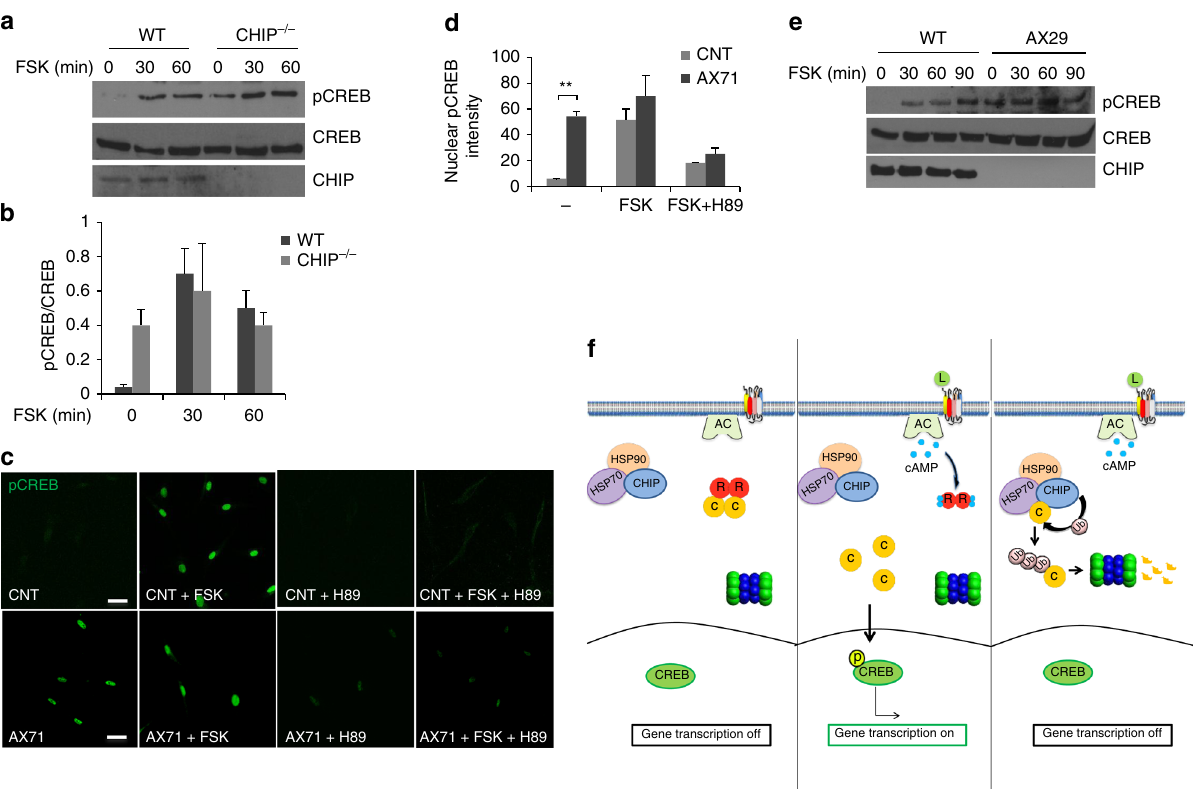
Fig. 8 Deregulated cAMP signaling in CHIP KO mice and in SCAR16 fi broblasts. a Mouse embryonic fi broblasts (MEFs) isolated from control mice (WT) or from CHIP KO mice (CHIP − / − ) were serum deprived overnight and then stimulated with FSK (40 μ M). Lysates were immunoblotted for pCREB, CREB, and CHIP. b Quantitative analysis of the experiments shown in a . A mean value ± S.E.M. of three independent experiments is shown. c Primary fi broblasts isolated from healthy volunteers (CNT) or from SCAR16 patient (AX71) were serum deprived overnight and stimulated with FSK (40 μ M) for the indicated time points. Where indicated, cells were pretreated with H89 (10 μ M). Formalin- fi xed cells were immunostained for pCREB and analyzed by confocal microscopy. Scale bar, 20 μ m. d Quantitative analysis of the experiments shown in c . A mean value ± S.E.M. of three independent experiments is reported. Student ’ s t test, ** p < 0.01. e Immunoblot analysis of lysates from a different SCAR16 fi broblasts (AX29) left untreated or stimulated with FSK (40 μ M) for the indicated time points using the indicated antibodies. f Schematic model of CHIP action on PKA signaling. Stimulation of speci fi c GPCRs activates adenylate cyclase (AC) and increases cAMP levels, which, in turn, dissociates the PKA holoenzyme. Free, active PKAc phosphorylates (amongst other substrates) CREB at serine 133 which drives CREB-dependent gene transcription. CHIP-driven ubiquitylation and proteolysis of PKAc desensitizes